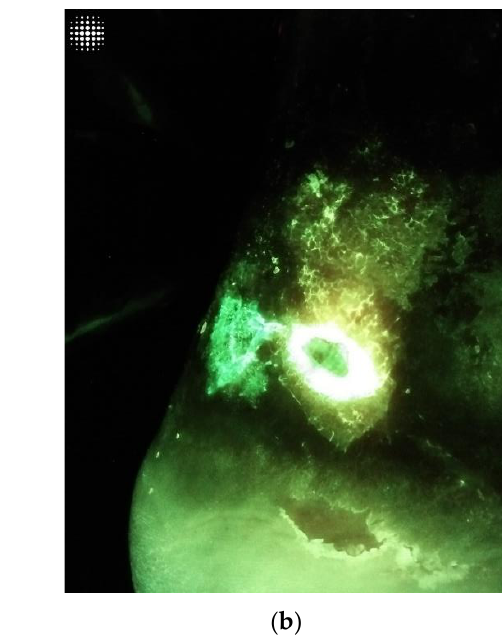
Figure 2. ( a ). Harmless wound on clinical inspection. ( b ) The same wound assessed under FL-imaging, demonstrating cyan positive signal, indicative of Pseudomonas . This was later confirmed by microbiology.